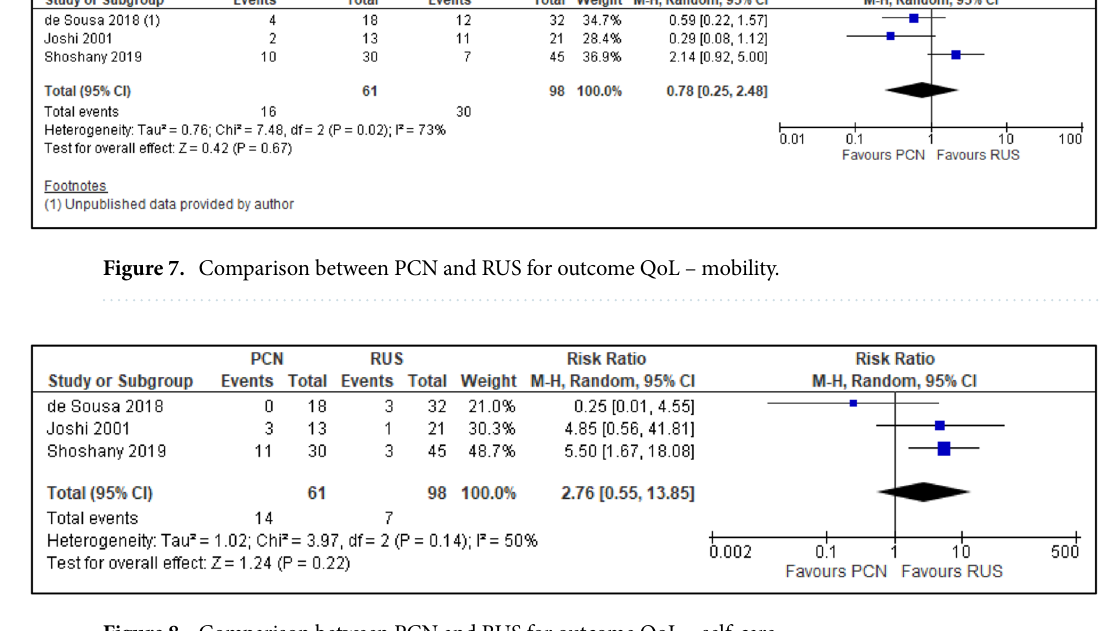
Figure 8. Comparison between PCN and RUS for outcome QoL – self-care.